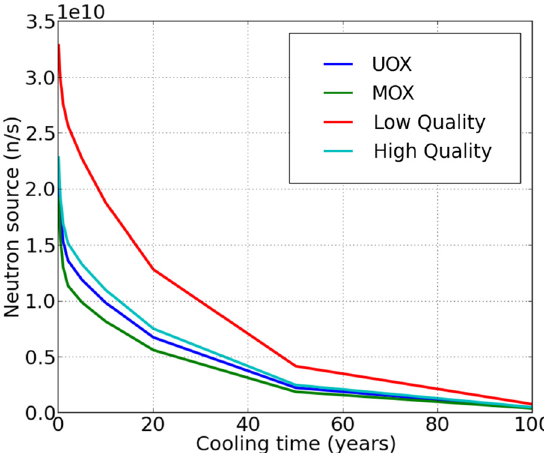
Fig. 5. Comparison of the neutron source per assembly for each of the initial americium feed.